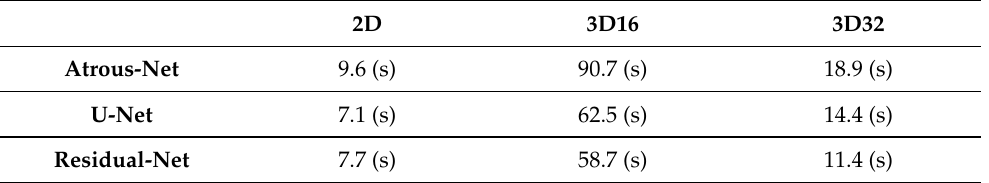
Table 30. Synthesis Times for Pelvis. Average time in seconds to synthesize a whole volume from the Pelvis Dataset using 2D networks and 3D networks reconstructing with stride 16 and